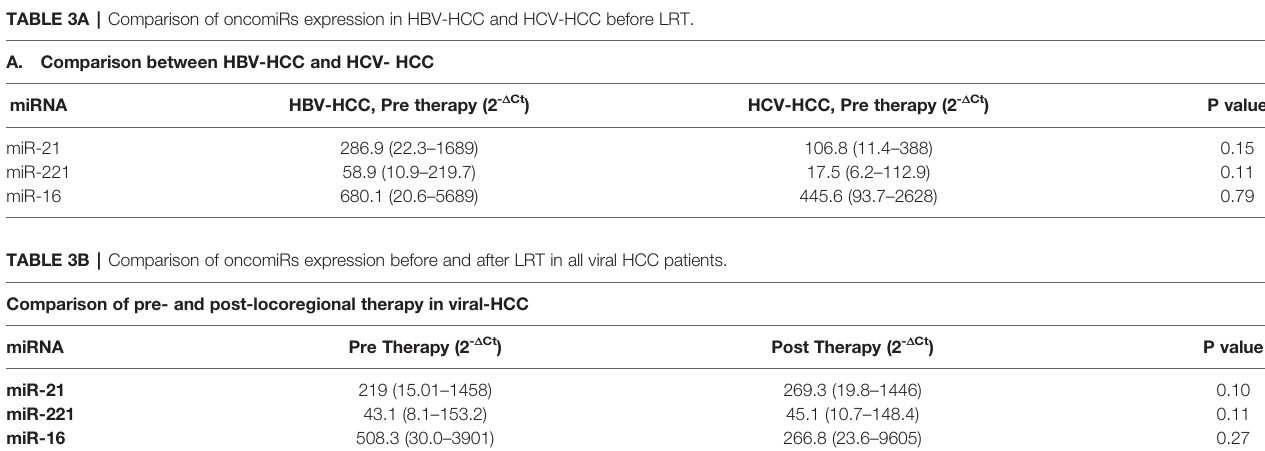
TABLE 4 | Comparison of demographic, clinical, and biochemical pro fi le among categories of CR, PR, PD, Group 1, and Group 2. S. No.